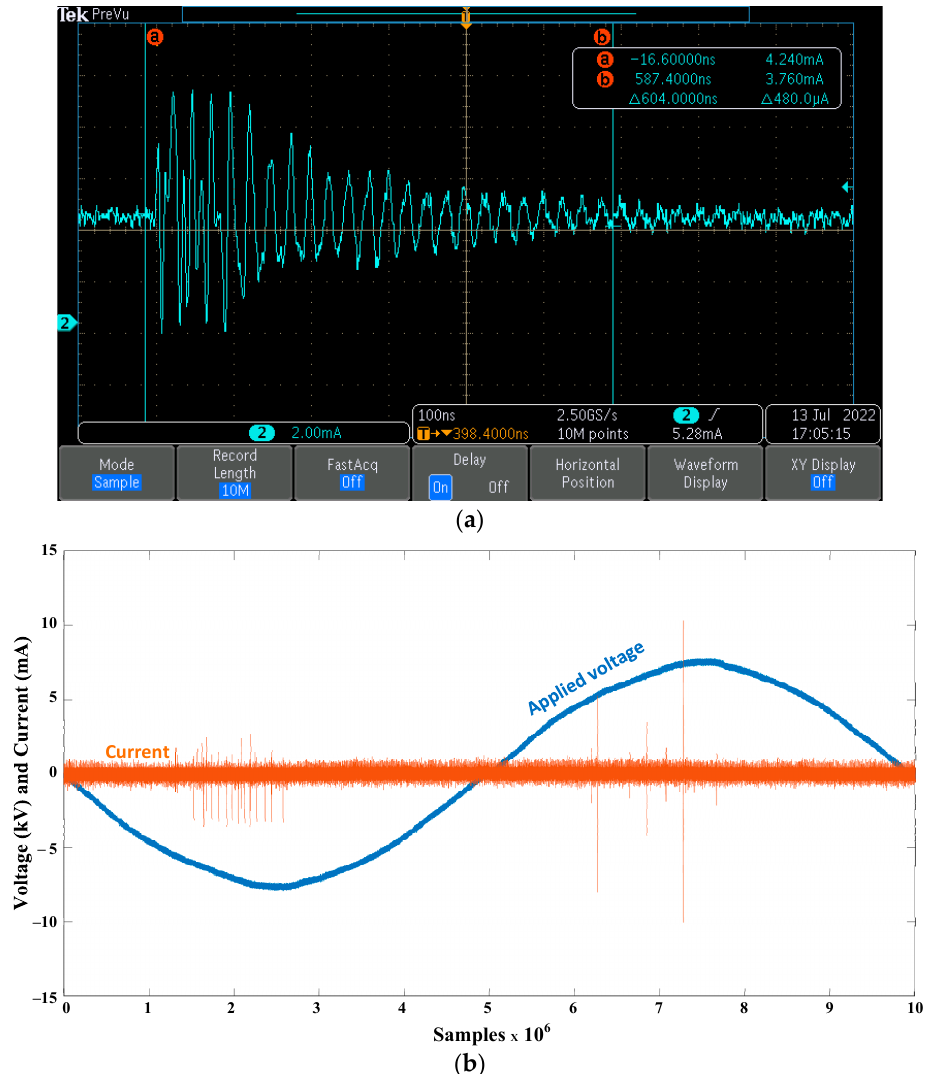
Figure 1. ( a ) Current profile of a discharge acquired with an oscilloscope. ( b ) Current and voltage profiles during a period of the voltage waveform acquired at a rate of 10 7 samples per period of the supply voltage.